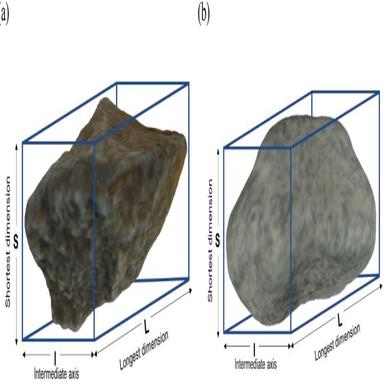
Comparison of the ballast type: (a) fresh and (b) used ballast.